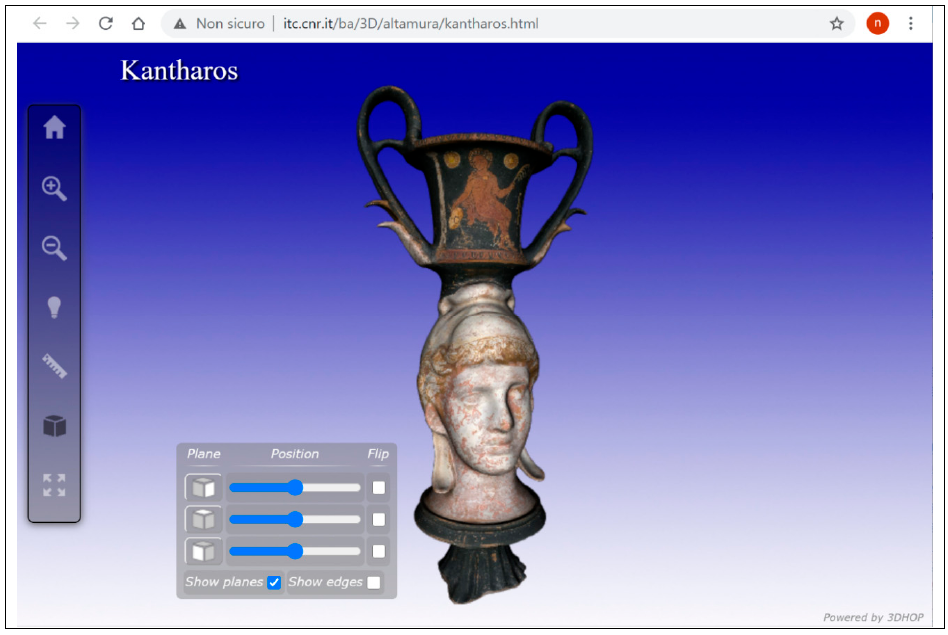
Figure 14. A 3D model viewer of a Kantharos (National Archaeological Altamura Museum) [49].